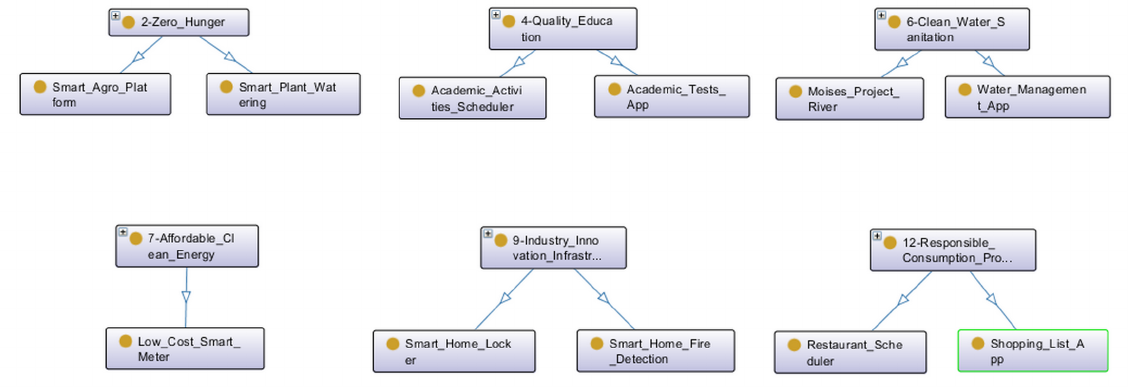
Figure 16. Projects related to SDGs 2, 4, 6, 7, 9 and 12.